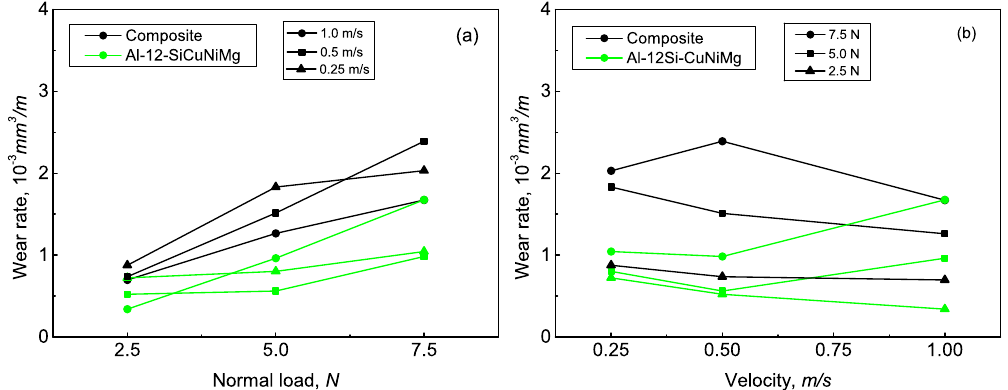
Figure 2. Wear rates of the Al–12Si–CuNiMg matrix alloy and the Al 2 O 3 fiber-reinforced composite as functions of ( a ) normal load and ( b ) sliding